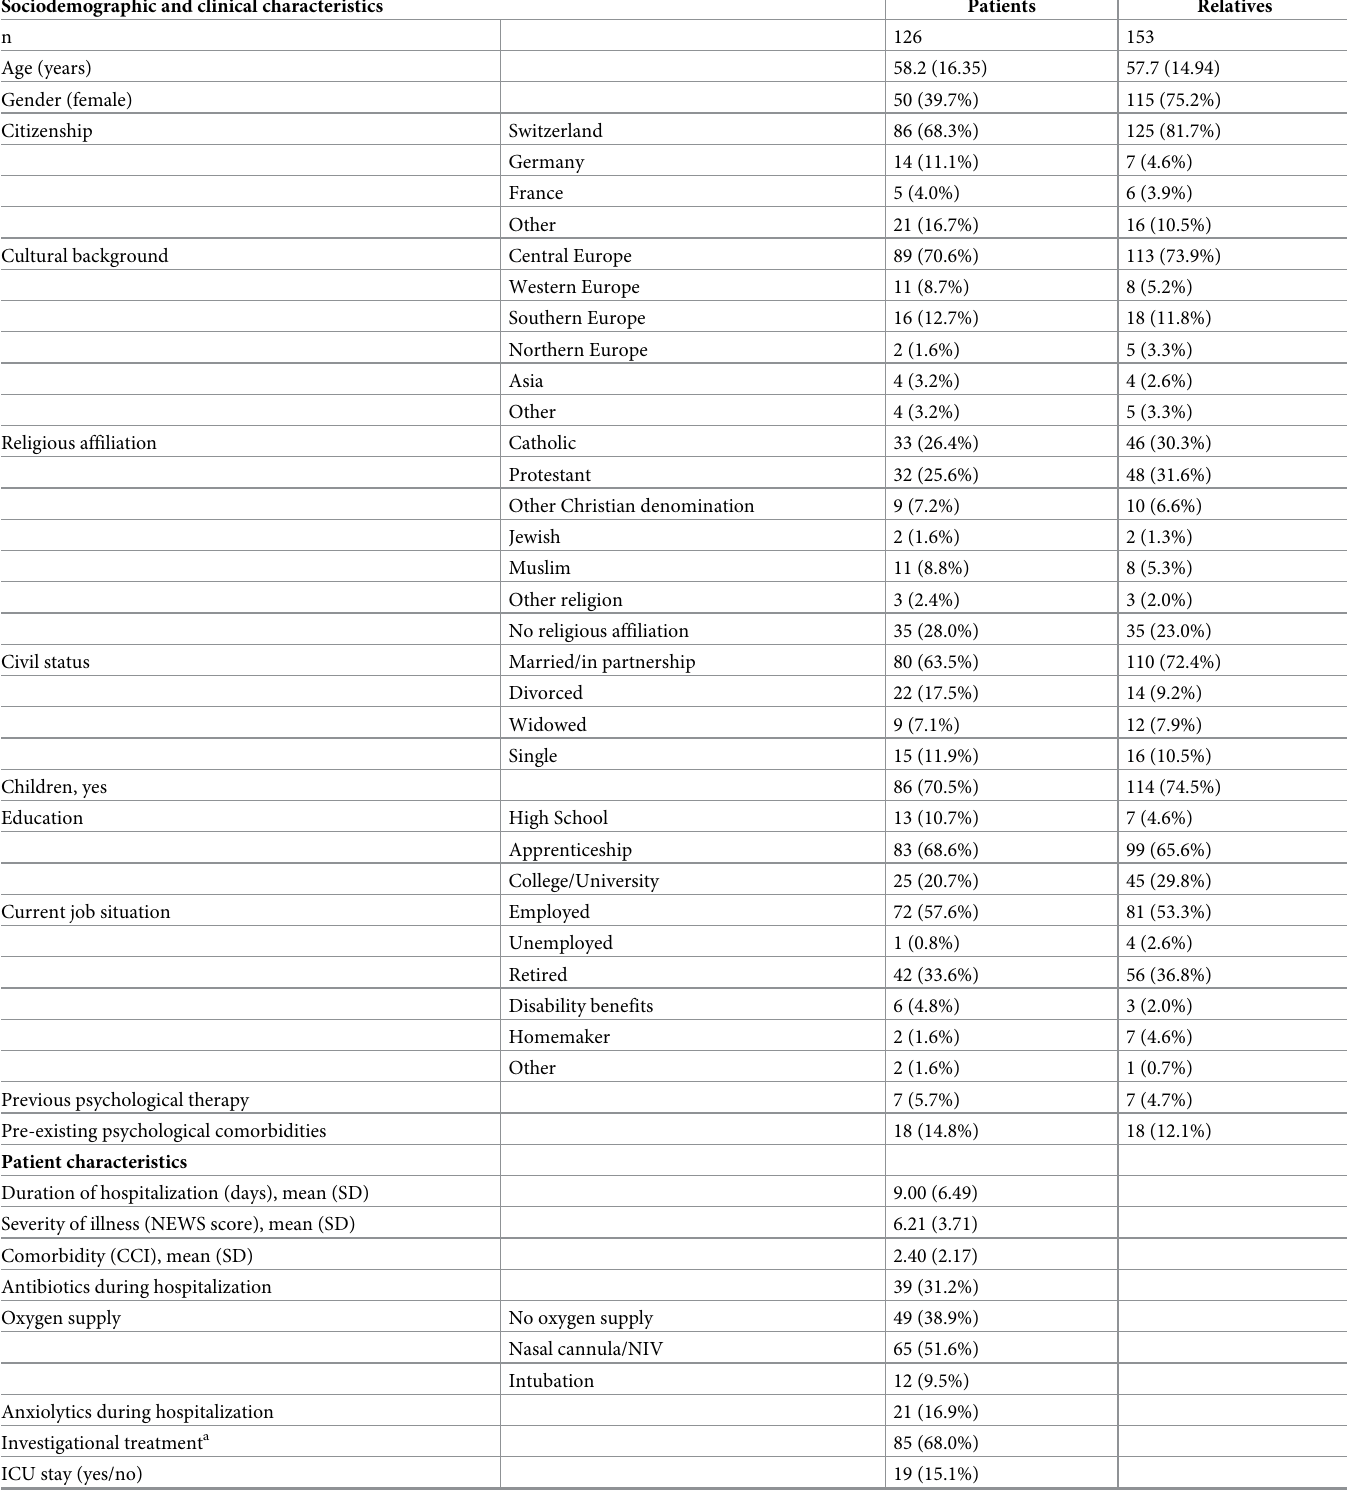
Table 1. Sociodemographic and clinical characteristics the study